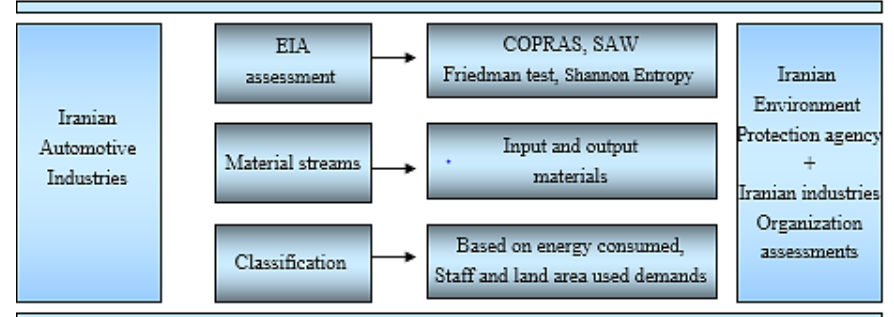
Figure 1. Diagram of the followed